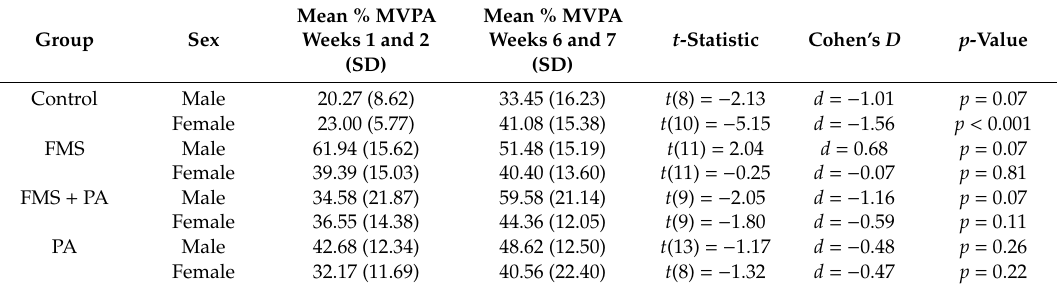
Table 2. Percentage of time spent in moderate to vigorous physical activity (MVPA) (means and standard deviations) for each group by sex for weeks 1 and 2 and weeks 6 and 7. t -statistics, Cohen’s d, and p -values are presented for the paired t -tests comparing weeks 1 and 2 with weeks 6 and 7 by group and